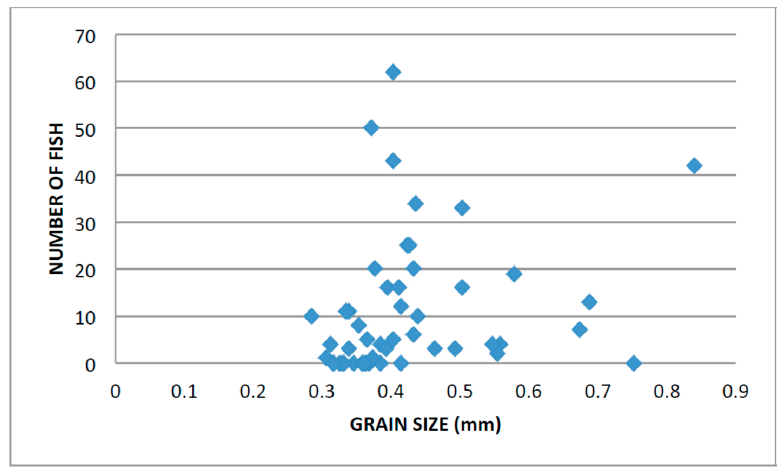
Figure 9. Numbers of fish captured in sediment samples from the San Juan Channel sand wave field. The highest numbers of fish (from 30 to 62 per sample) were collected in sediment samples with mean grain sizes of approximately 0.35 to 0.5 mm.